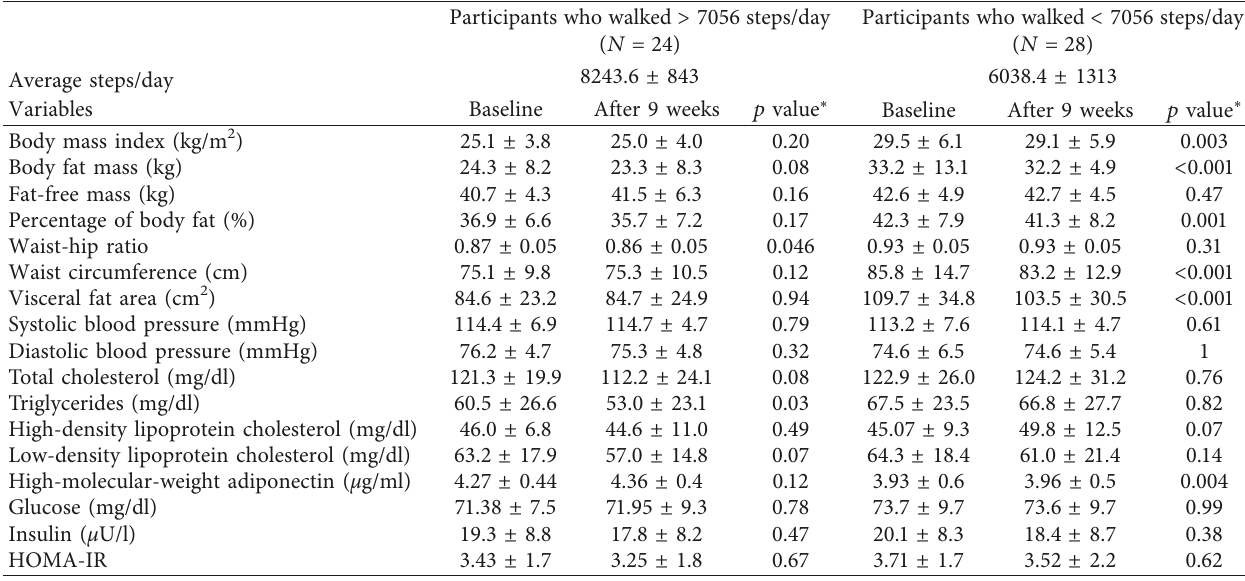
Table 4: Comparisons of means of obesity measures, blood pressure, and biochemical parameters in participants who walked more than and less than average steps per day (7056 steps) before and after intervention ( N � 52).